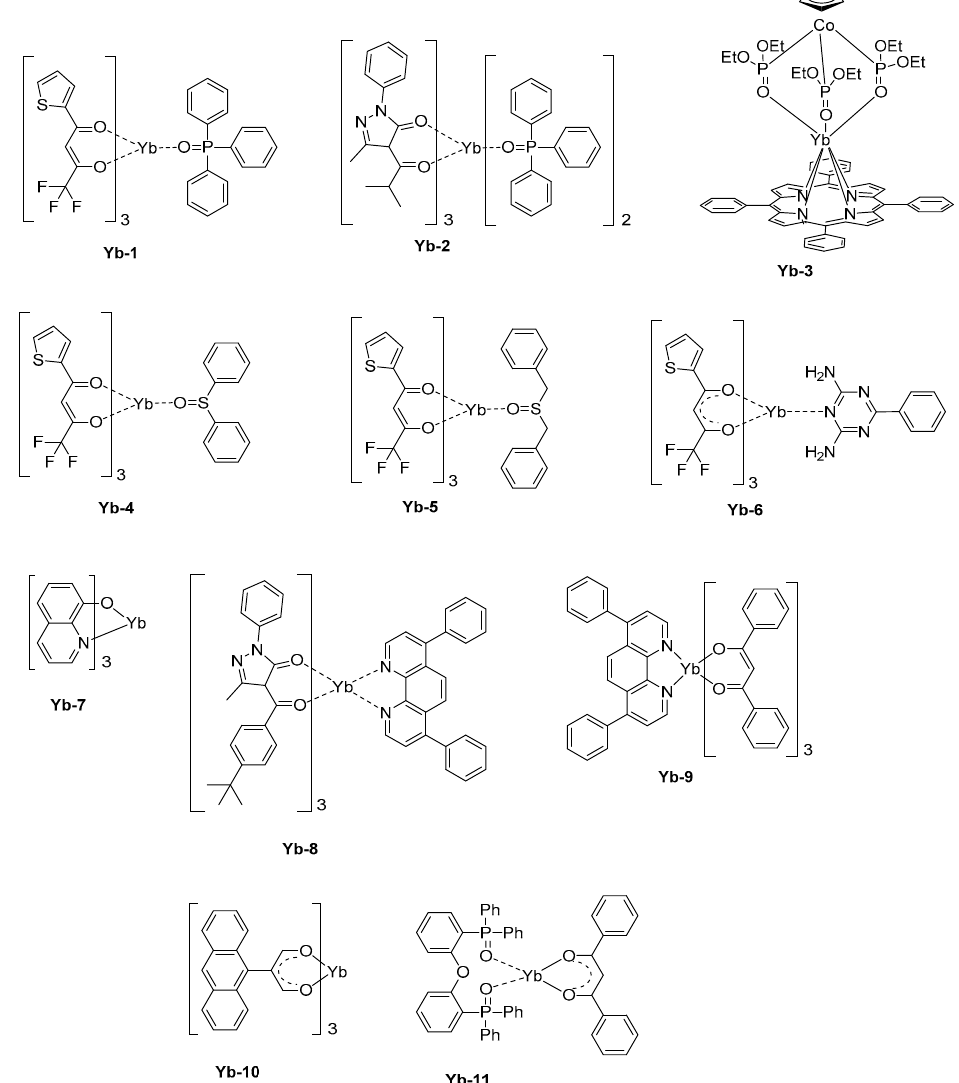
Figure 10. Yb-based near-infrared (NIR) emitters for light-emitting diodes.